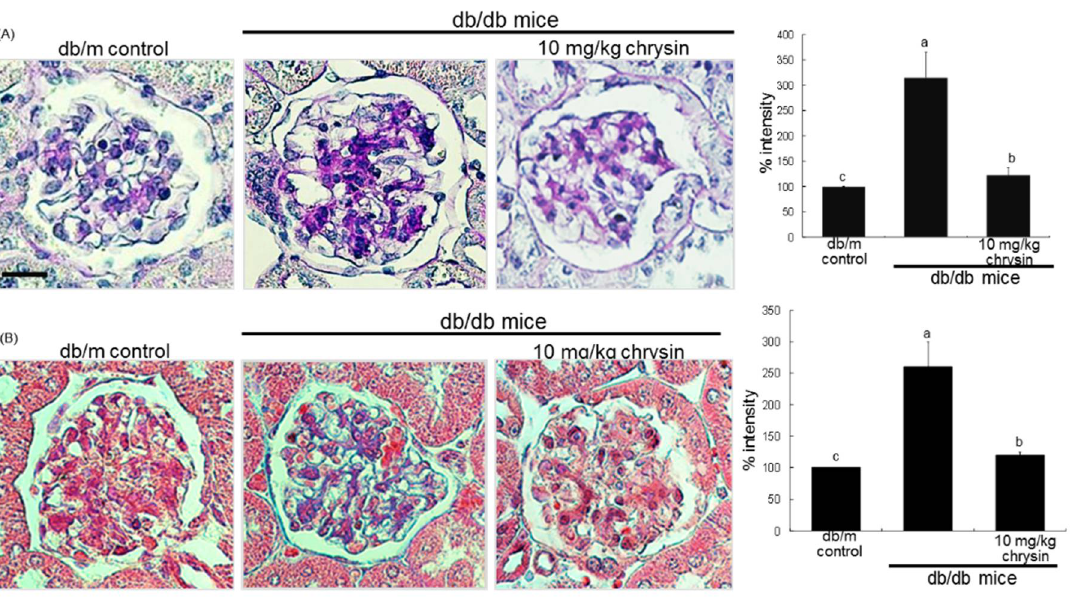
Figure 3. Inhibitory effects of chrysin on histological alterations ( A ) and collagen fiber deposition ( B ) in diabetic glomeruli. Diabetic mice were orally administrated with 10 mg/kg chrysin for 8 weeks. PAS staining was done in glomeruli of chrysin-treated db/db mice and nuclear counter-staining was done with hematoxylin ( A ). Masson’s trichrome staining were performed for glomerular collagen fibers ( B ) The collagen fibers were stained in blue and muscle fibers were stained in red. Each photograph is representative of at least four animals. Scale bar = 25 μm. The relative staining intensity was measured and the respective values are expressed as mean ± SEM ( n = 4 mice in each group). Values in bar graphs not sharing a same lower case indicate significant different at p < 0.05.